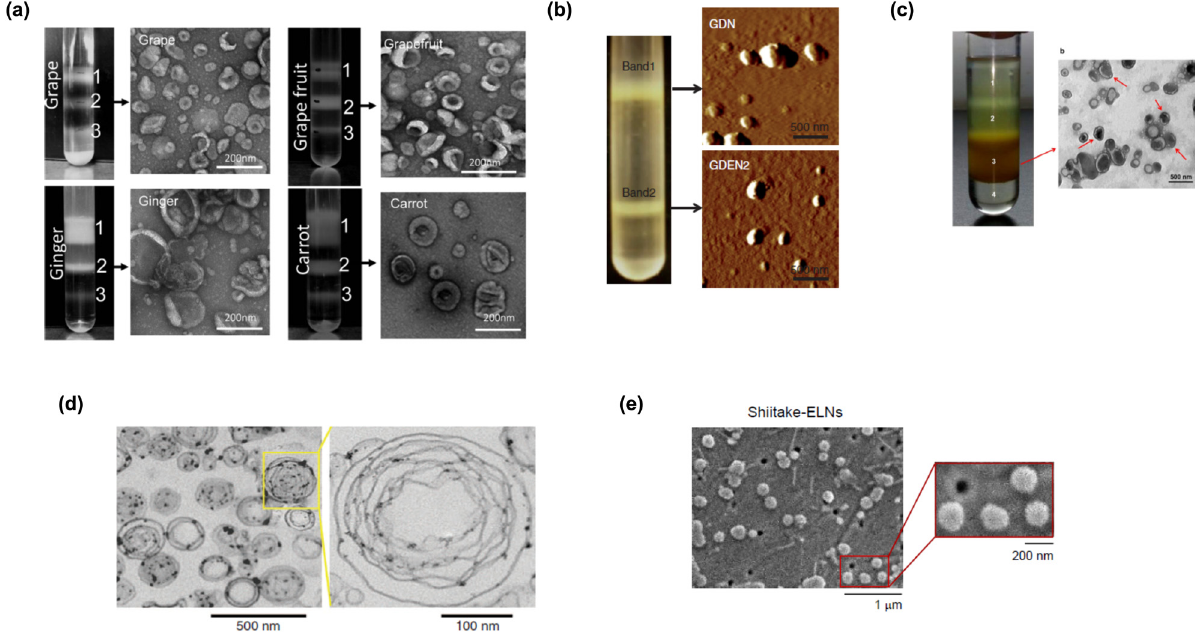
Figure 2: Physical characteristics of PDNVs obtained from di ff erent edible plants. ( a ) Three bands were formed after sucrose gradient ultracentrifugation. NVs from grape, grapefruit, ginger, and carrot from the 30%/45% interface were visualized by the electron microscopy. Reprinted from ref. [ 41 ] with permission from John Wiley and Sons. ( b ) Two bands from sucrose - banded ginger rhizome root -